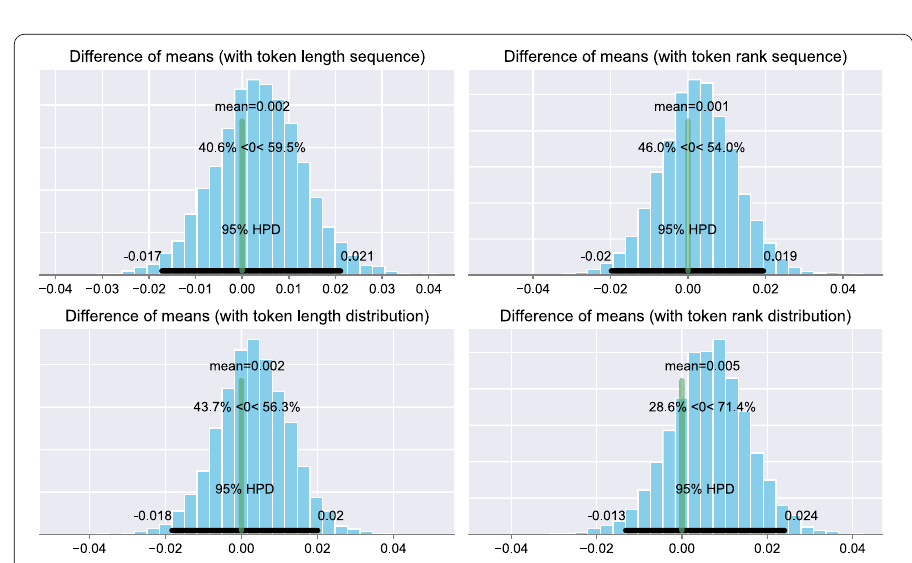
Figure 11 Posterior distributions of the differences of means between log loss values after considering the features from a second functional language